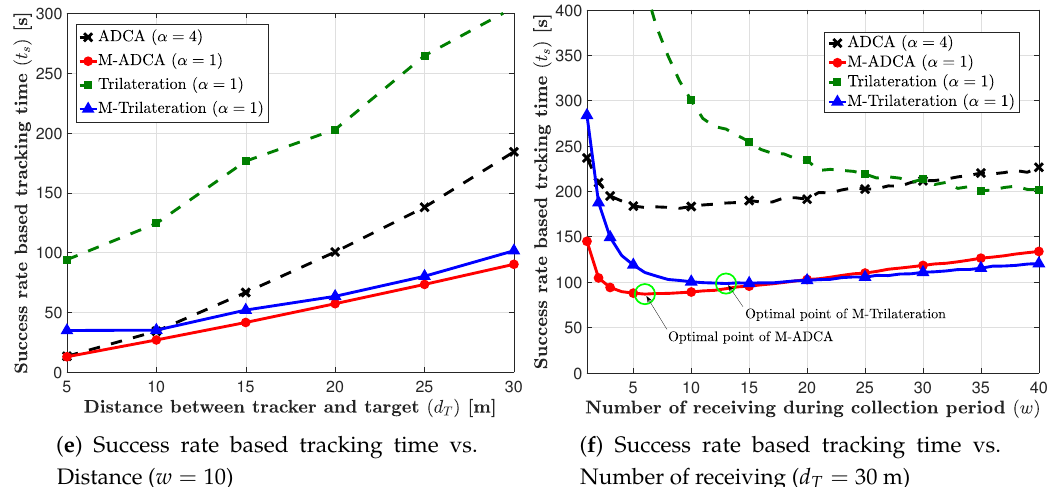
Figure 7. Comparison of performance of the proposed tracking algorithms and trilateration algorithm. ( d max m =